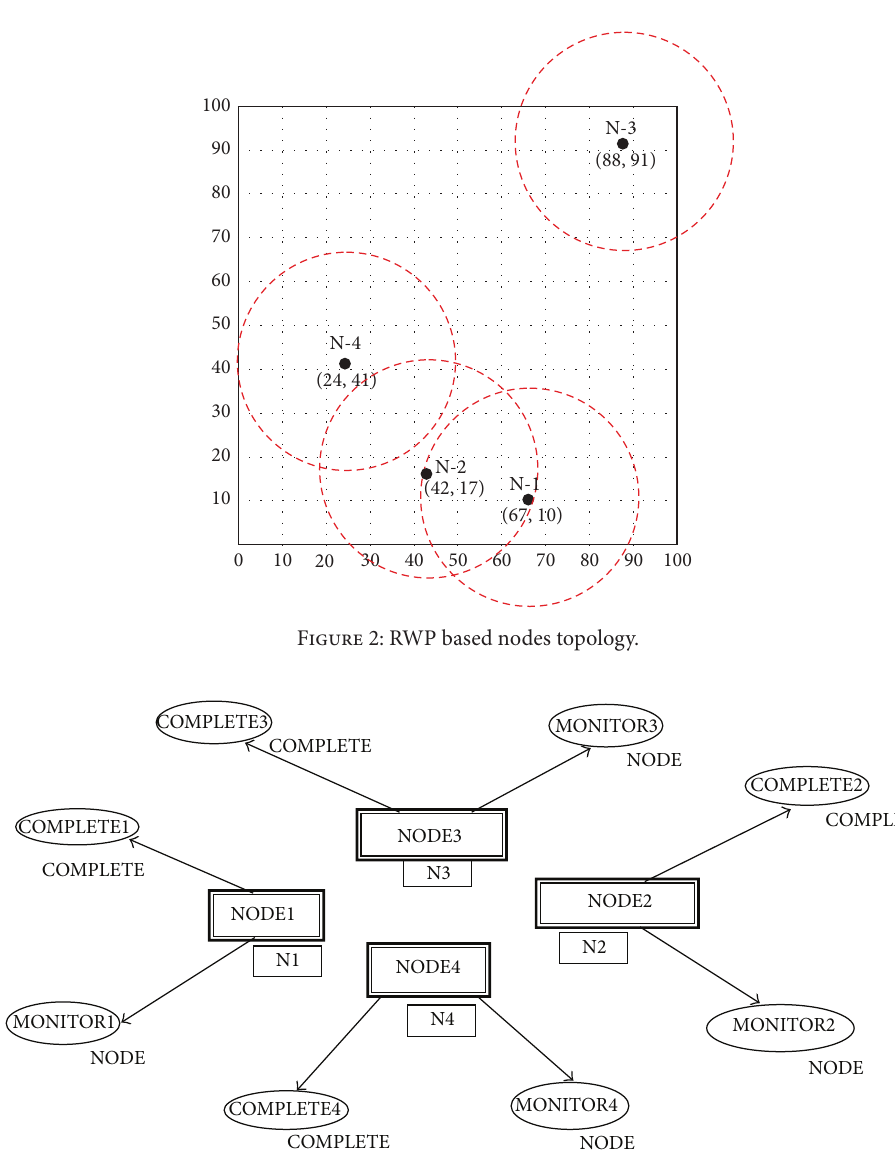
Figure 3: Scenarios page, top level